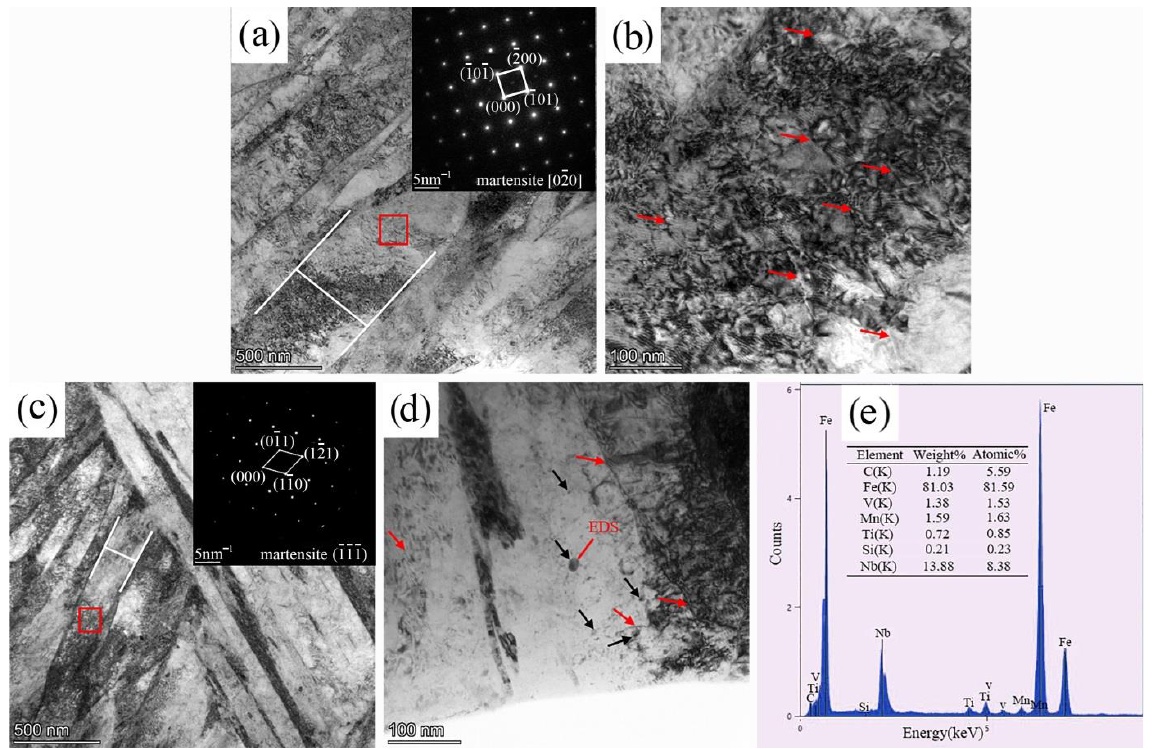
Figure 4. TEM images showing ( a ) lath martensite and ( b ) dislocation tangle in A-1200 steel, as well as ( c ) lath martensite and ( d ) precipitates in A-1800 steel and ( e ) the corresponding EDX results of the carbide marked by red arrows in Figure 4d. The inset maps in Figure 4a,b show the SAD patterns of the corresponding red box regions.